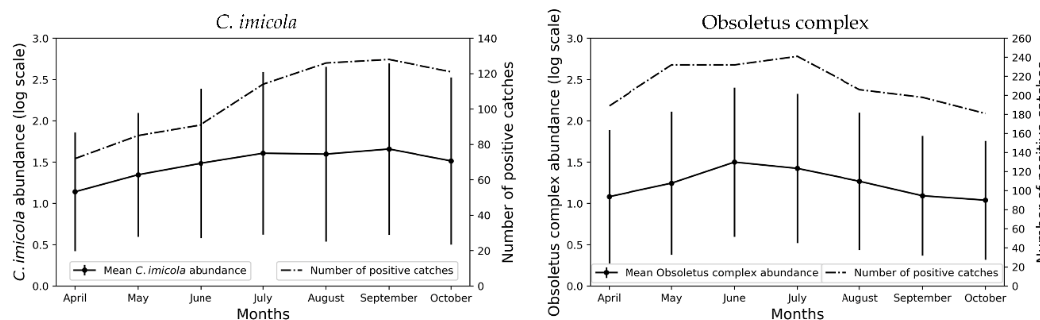
Figure 1. Mean abundance of Culicoides spp. in positive sampling sites and the number of positive catches for the 331 sampling site observations for each month of the study period. The abundance of Culicoides spp. was transformed to log 10 ( C + 1), C being the number of Culicoides spp. Vertical lines show the standard deviation of the mean for each month.